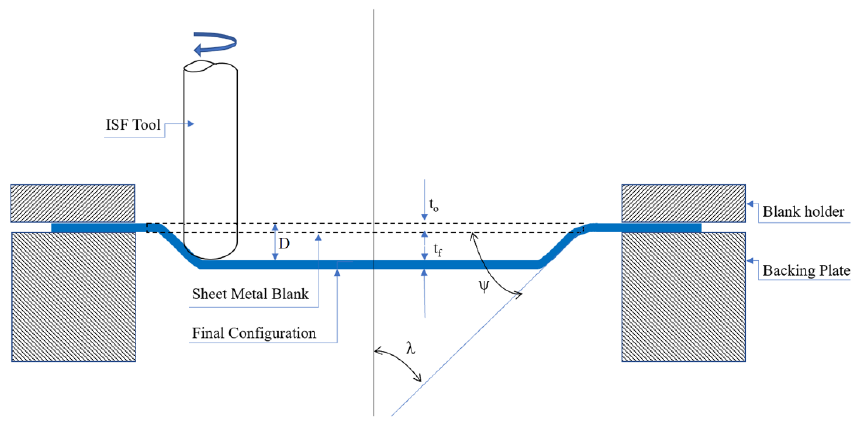
Figure 1. Symmetric SPIF Schematic representation.